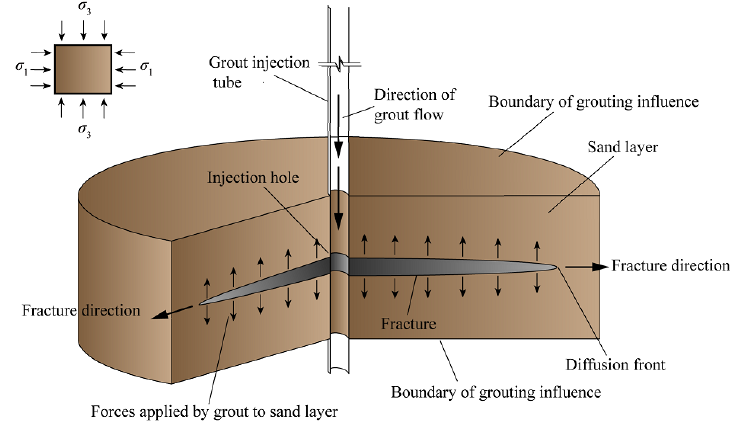
Figure 3. Sketch of fracture–compaction grouting process.